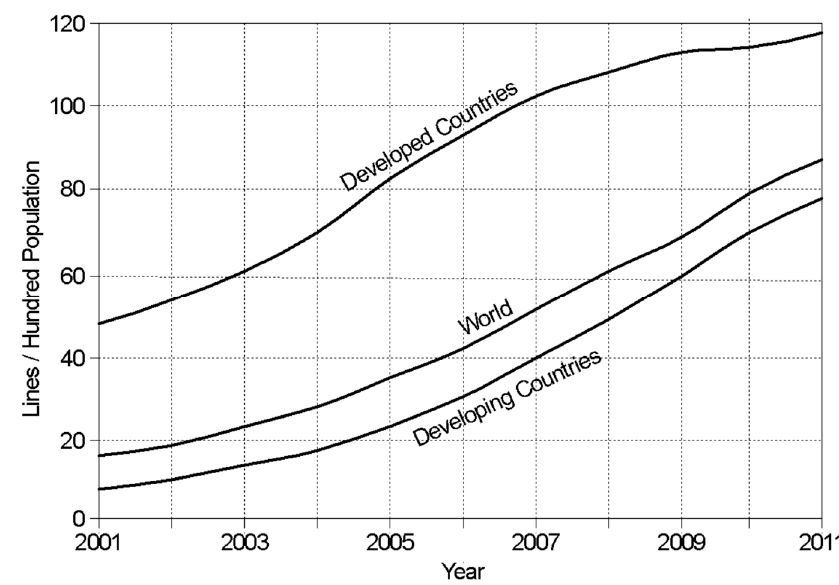
Figure 1. Cellular penetration showing the dramatic increase in developing countries over the last decade, adapted from [5].